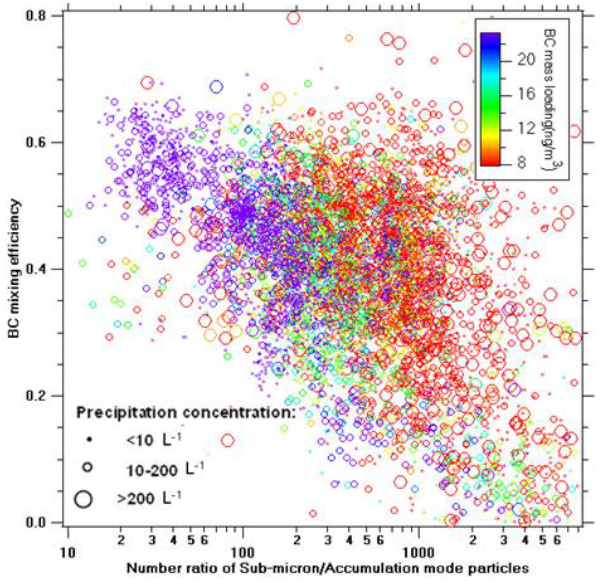
Fig. 10. Fig. 10. BC mixing efficiency as a function of the ratio between sub-micron and accumulation mode aerosol number, colored by rBC mass loading. The size of the markers denotes the intensity of precipitation.